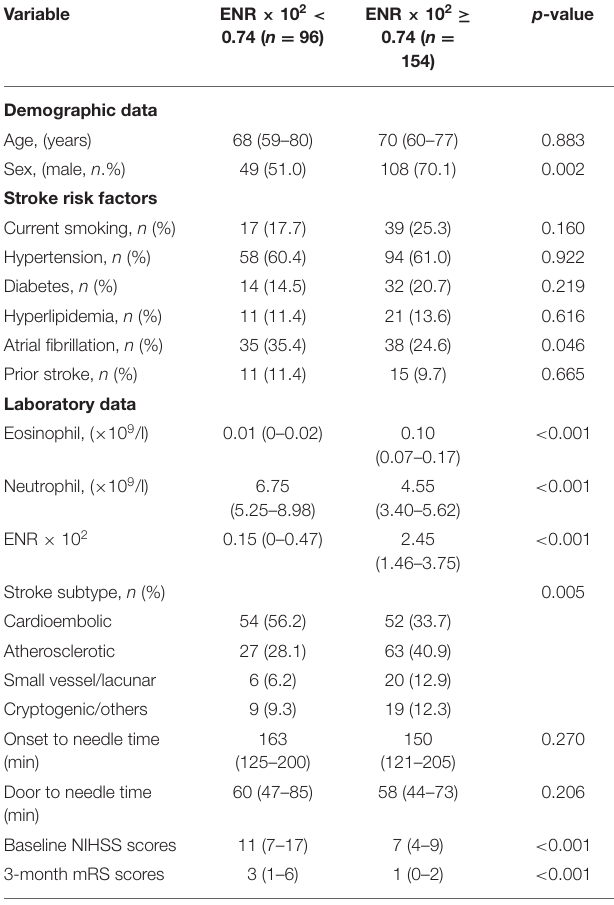
TABLE 2 | Comparisons of baseline characteristics and 3-month outcomes between ENR